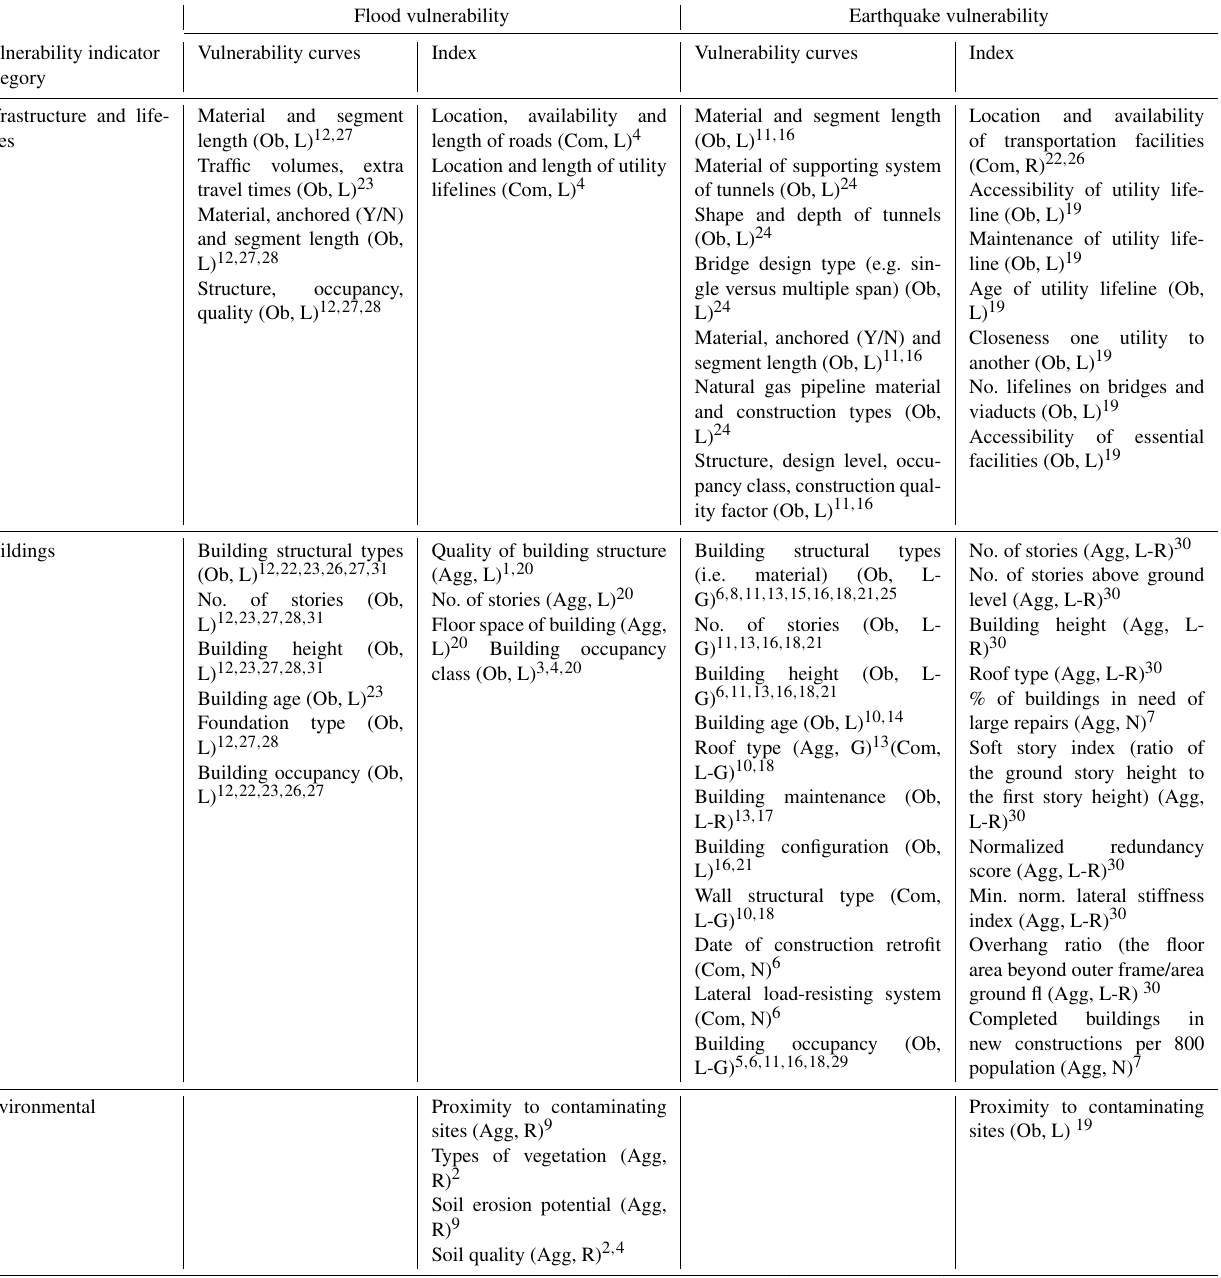
Table 1. Overview of physical earthquake and flood vulnerability assessment